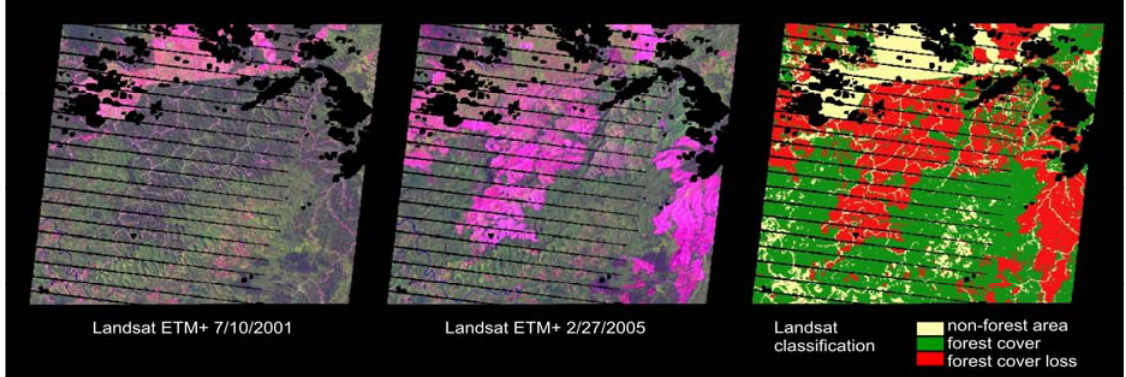
Figure 2. Example block for the 2000 to 2005 epoch, centered at 3.08 degrees North, 113.58 degrees East, Sarawak state,